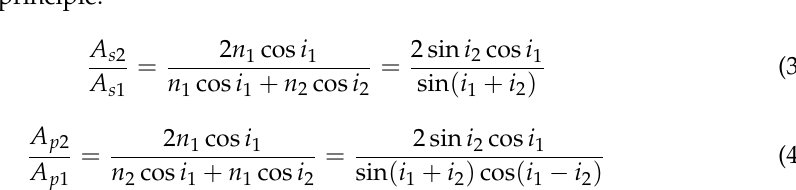
Figure 7. Reflection and its schematic diagram [44]. From the microscopic point of view of materials, the laser absorptivity and particle size distribution of different materials are different. The main reason is that the types of raw materials that make up the materials are different. During SLM processing, differ- ences in laser absorptivity and particle size distribution lead to differences in the pro- cessed parts. Research shows that the higher the laser absorptivity of materials, the finer the particle size distribution, and the better the SLM processing results. 3. Metal Materials Although the development of SLM has gradually accelerated and is becoming com- mercialized, there are still few available metal materials [45,46]. Next, several common metal materials used in SLM equipment will be introduced, such as aluminum alloy, mag- nesium alloy, titanium alloy, and stainless steel. 3.1. Aluminum Alloy Compared with many other SLM candidate materials, the treatment of aluminum alloy is more complicated [47]. This is mainly due to the lightweight nature and high flu- idity of aluminum, which shows a high reflectivity wavelength range for typical SLM la- sers, and has high thermal conductivity [48]. The absorption of aluminum by laser is poor; this indicates that it is necessary to quickly dissipate the heat of parts after high laser power processing [49]. Aluminum powder is very sensitive to oxidation [50]. Therefore, when printing aluminum alloy, attention must be paid to the oxygen content to avoid oxidation by oxygen in the air, and passivation [51]. Aluminum alloy is also the most widely used. It can be found in daily life and other fields [52]. The SLM aerospace alumi- num alloy specimen is shown in Figure 8 ， The performance comparison of common alu- minum alloy materials is shown in Table 2.